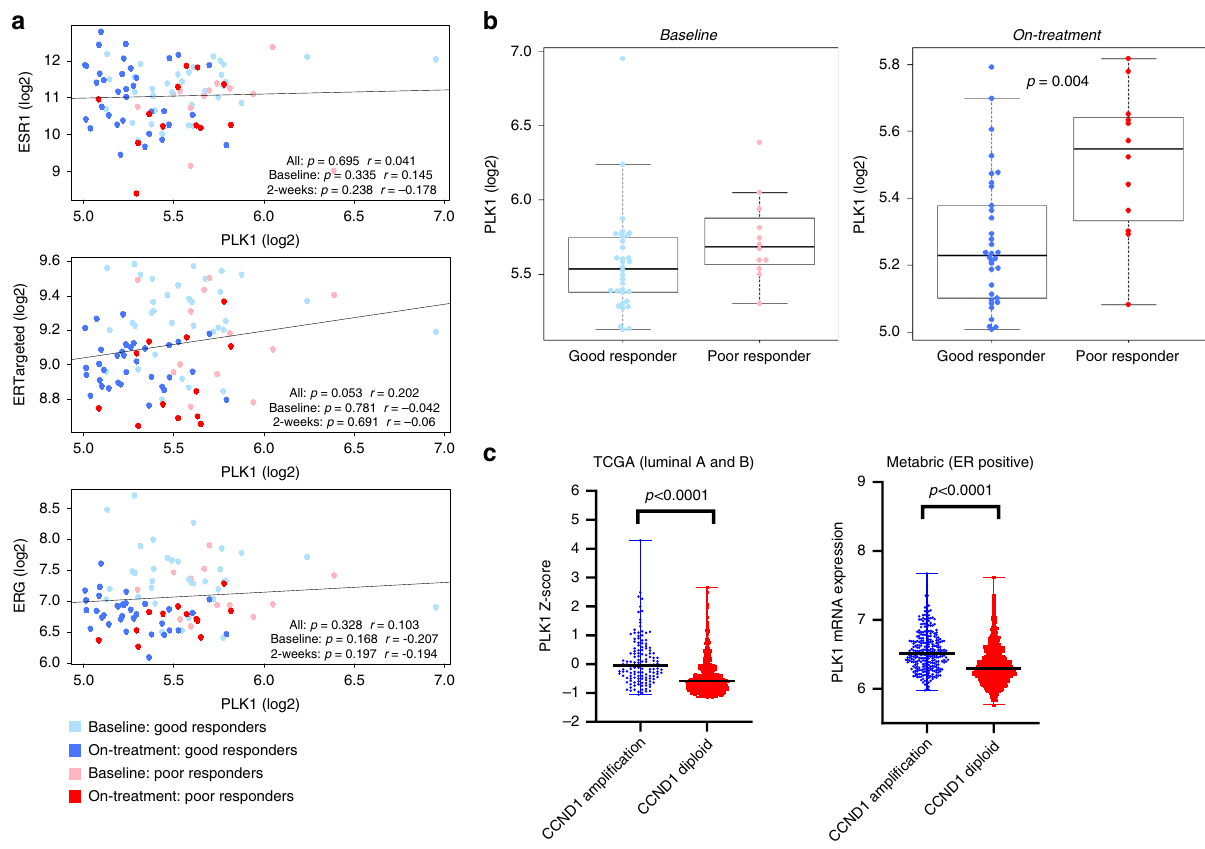
Fig. 7 PLK1 correlation plots in clinical samples. a Correlation plots between PLK1 and ESR1, ERTargeted or ERG metagenes. Light blue dots — good responders at baseline; light red dots — poor responders at baseline; dark blue dots — good responders on-treatment (2 weeks); Dark red dots — poor responders on-treatment (2 weeks). Pearson correlation coef fi cients are shown. b Boxplot (box representing the median, fi rst and third quartiles; whiskers representing min to max excluding outliers) highlighting the association of PLK1 expression with good and poor responders to anastrozole both at baseline and on-treatment. p Value < 0.05 by Student t test is shown. Light blue dots — good responders at baseline; light red dots — poor responders at baseline; dark blue dots — good responders on-treatment (2 weeks); dark red dots — poor responders on-treatment (2 weeks). c PLK1 expression in ER-positive tumours of TCGA and Metabric according to CCND1 ampli fi cation. Data are presented as scatter dot plot with line indicating the median with